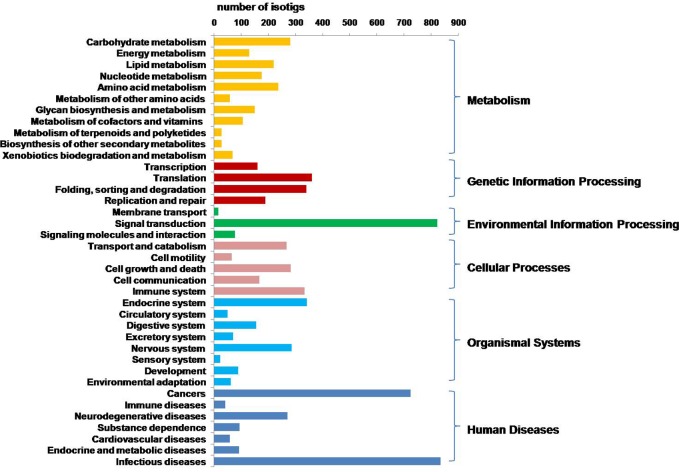
KEGG biochemical mappings for C. hongkongensis transcriptome.